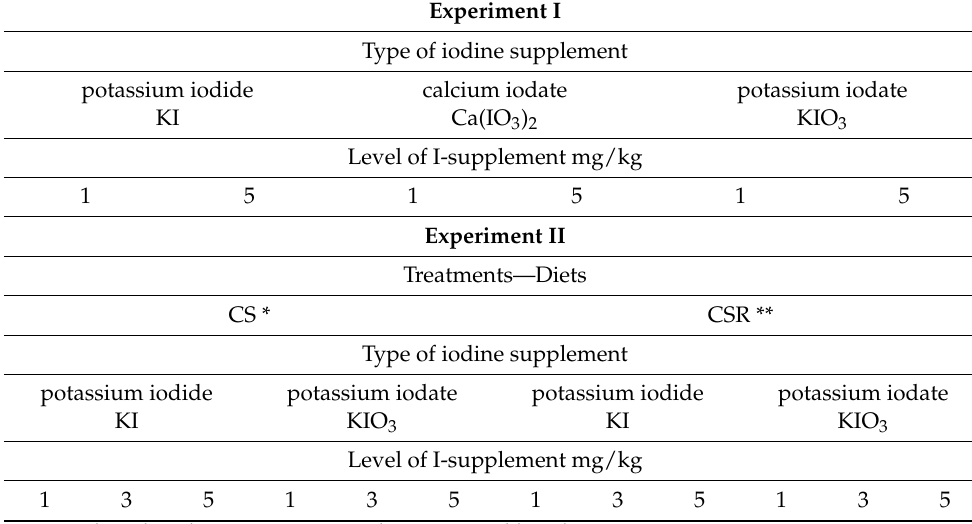
Table 1. Design of the